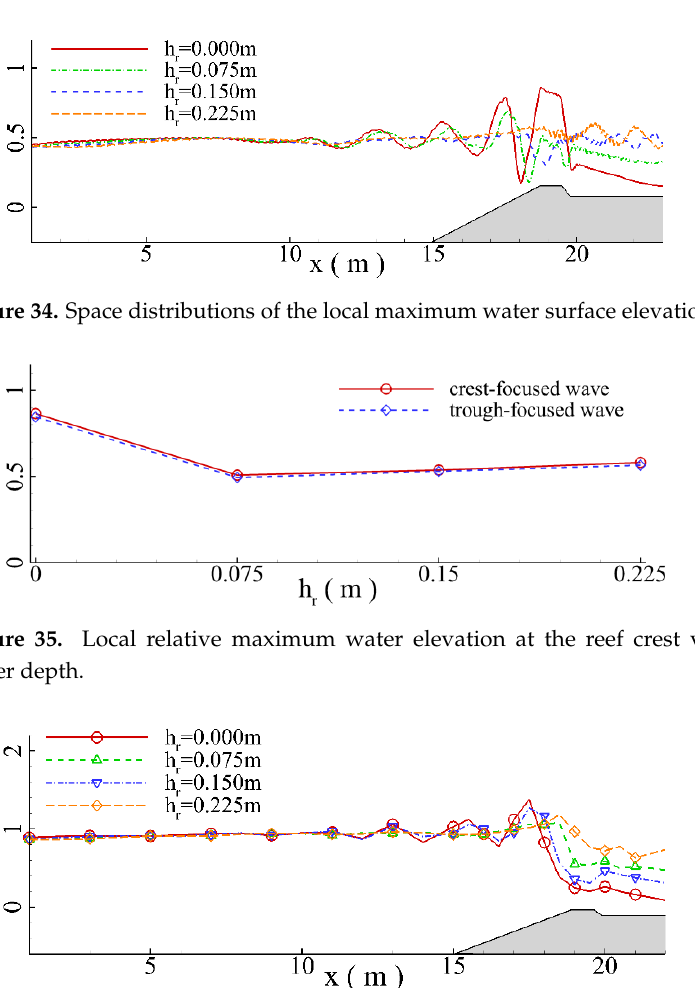
Figure 36. Space distributions of the local maximum depth-averaged velocity.